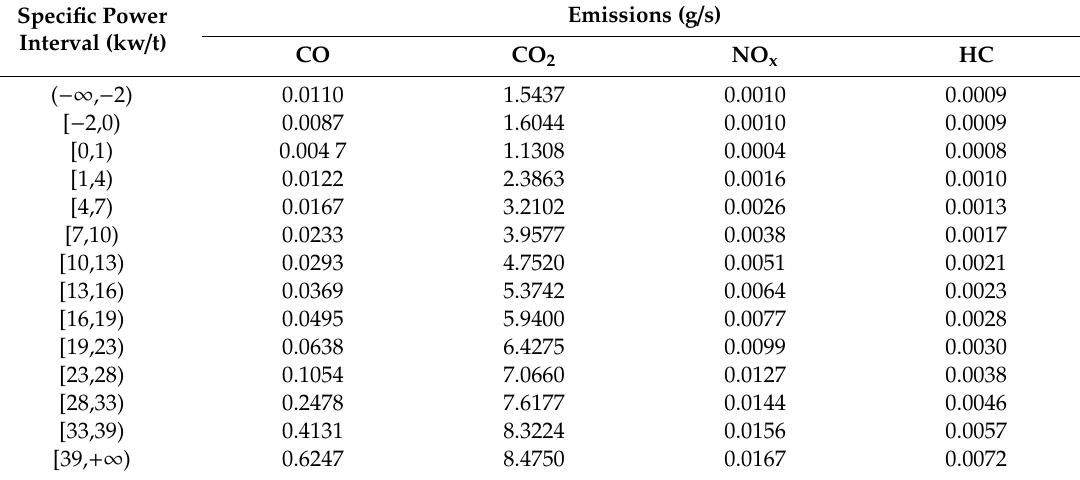
Table 2. Exhaust emission rate of various types of cars under di ff erent specific